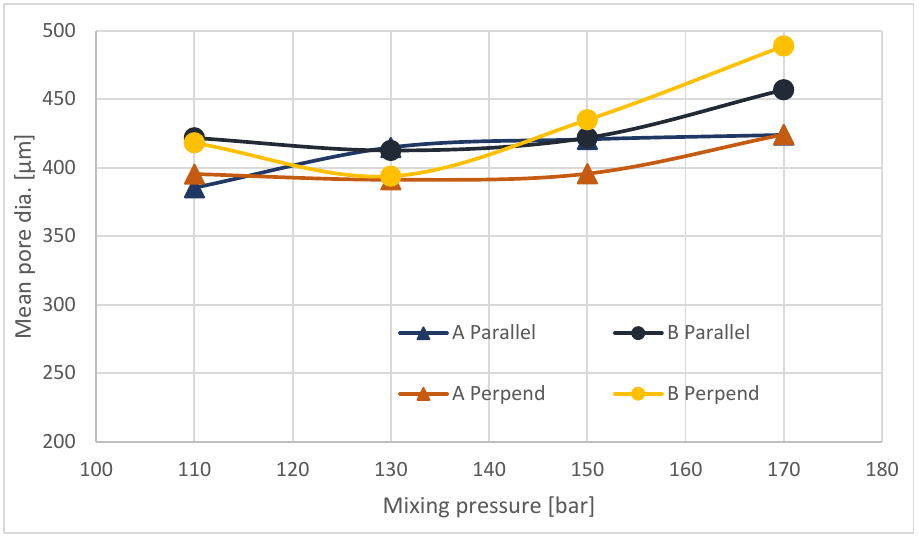
Figure 5. Mean pore diameter for parallel and perpendicular to the growth direction cross sections.